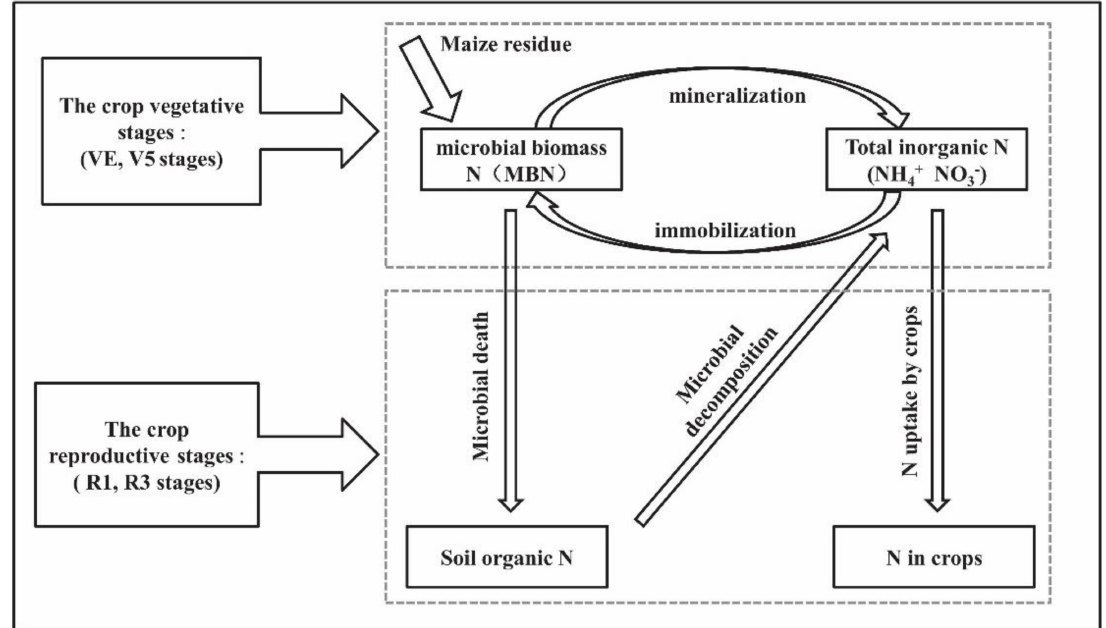
Figure 7. A conceptual model of nitrogen utilization by microbes and crops at different stages of maize growth when maize residues are returned to the